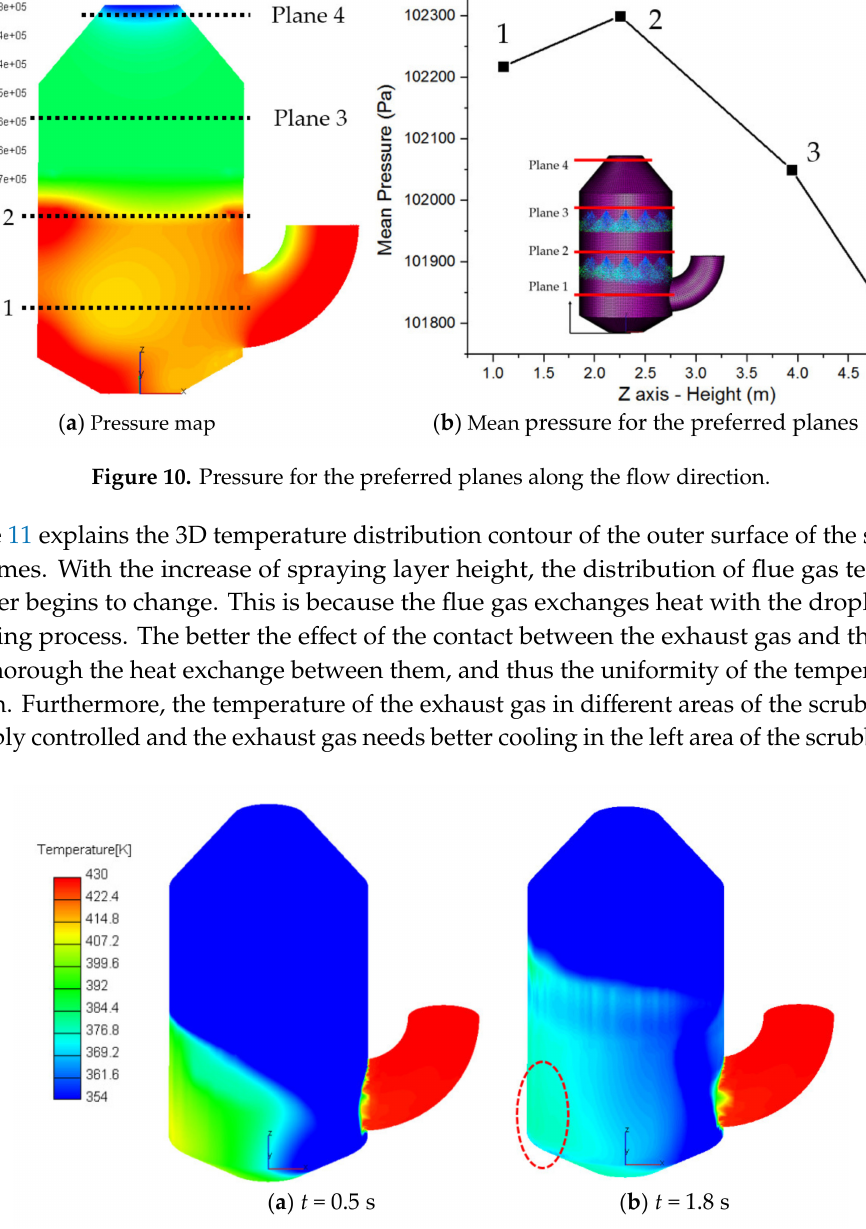
Figure 11. Temperature distribution of the scrubber